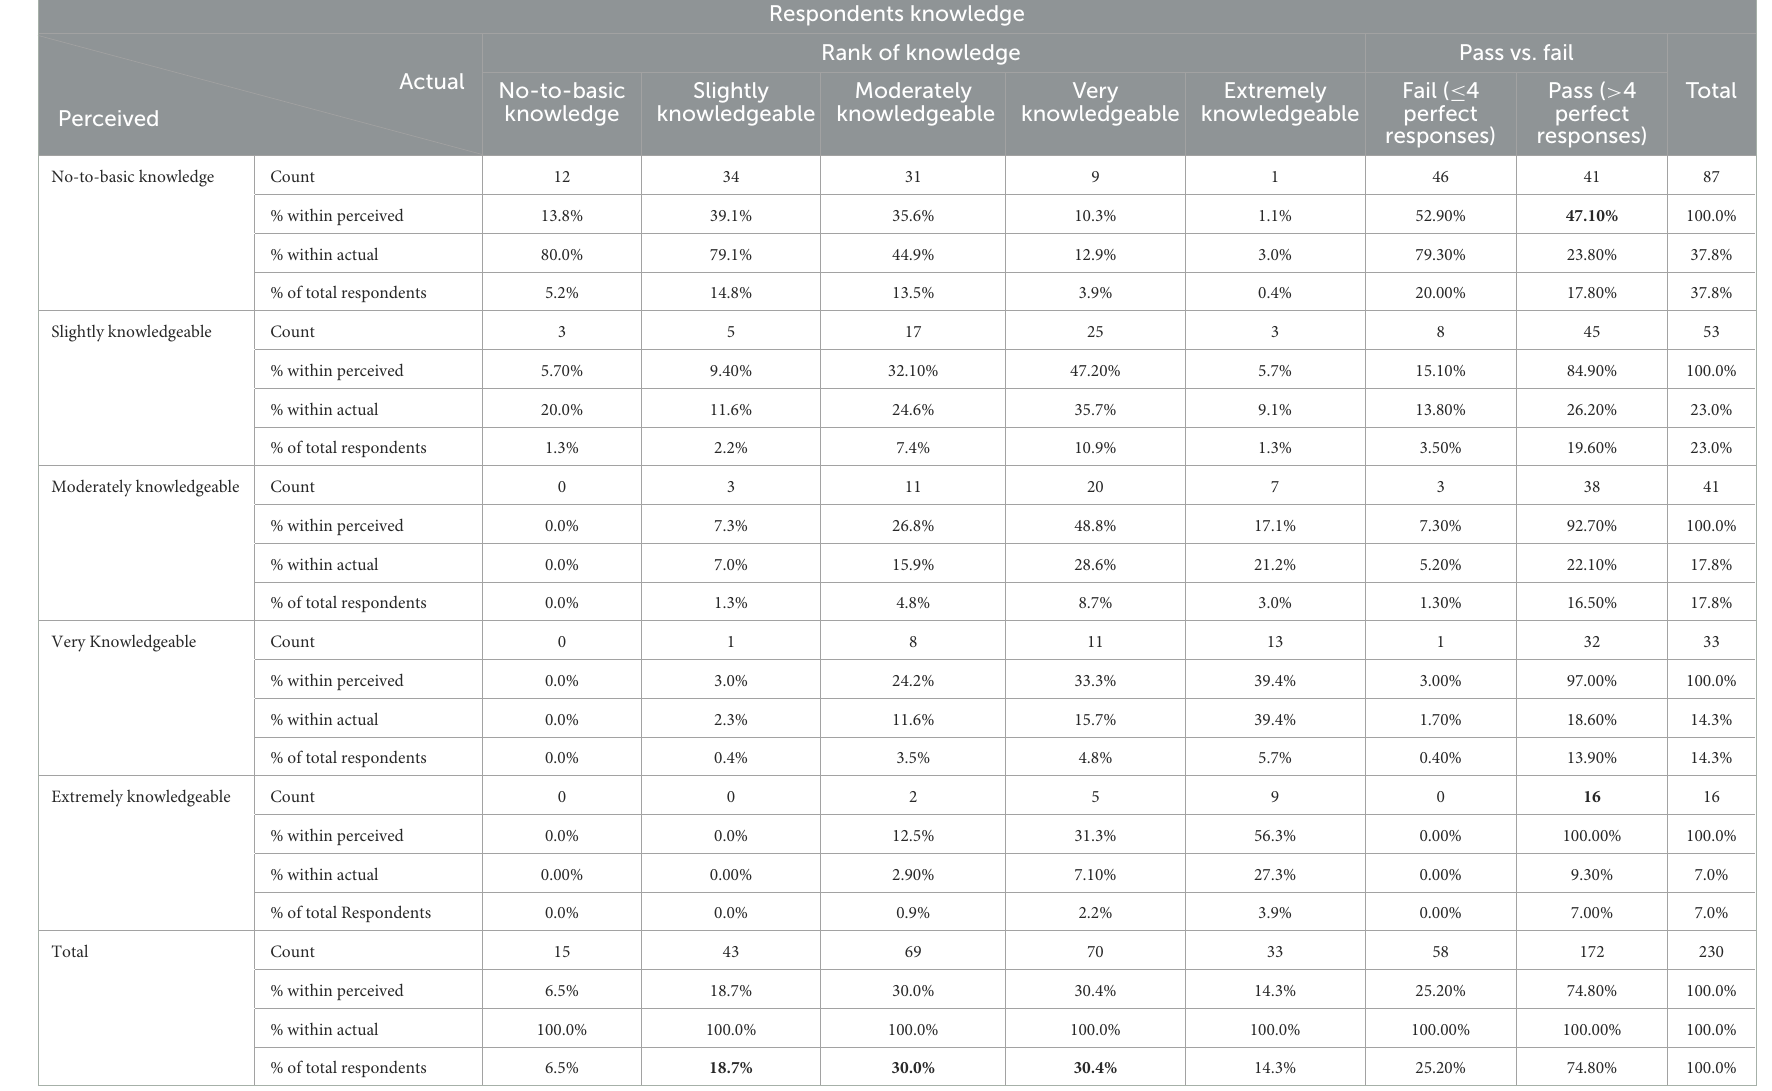
TABLE 3 A cross tabulation of respondents perceived vis-à-vis actual CE